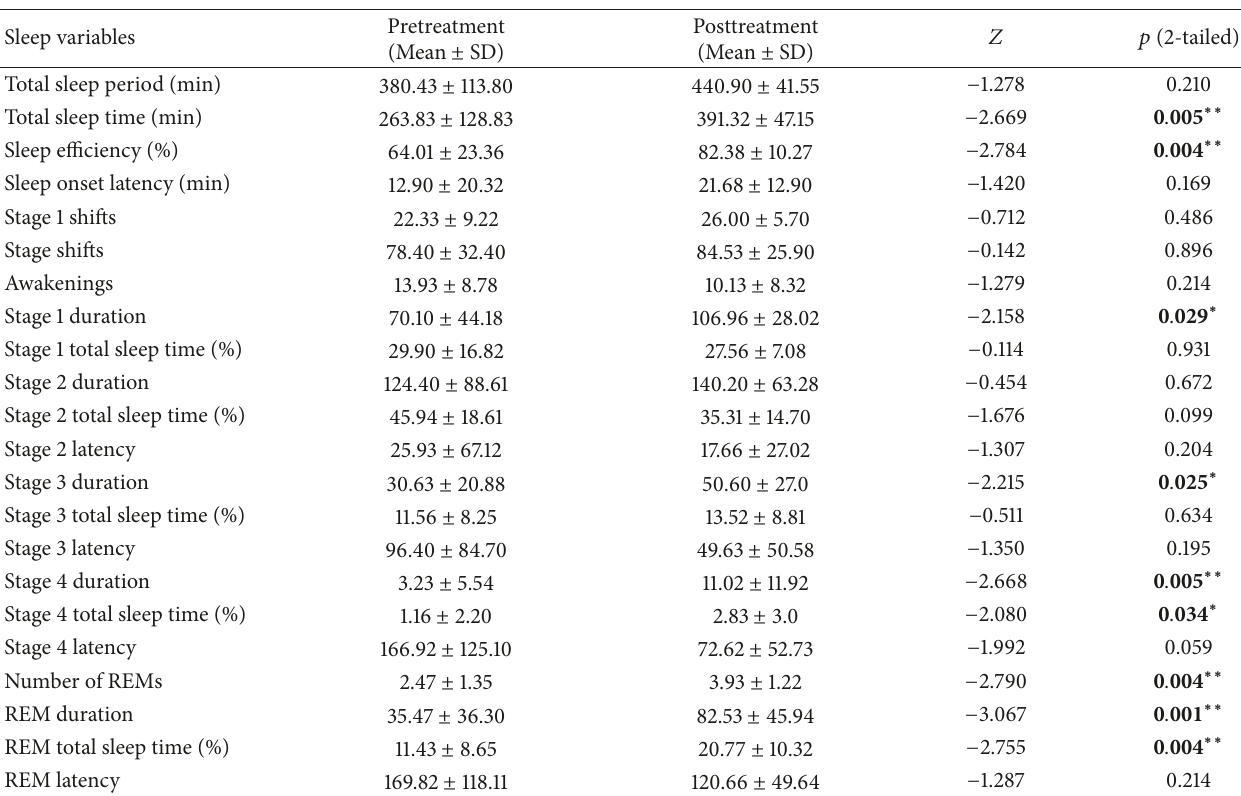
Table 3: Comparison of pre- and posttreatment polysomnography parameters (Wilcoxon Signed-Ranks Test–Monte Carlo Method; 𝑁 = 15